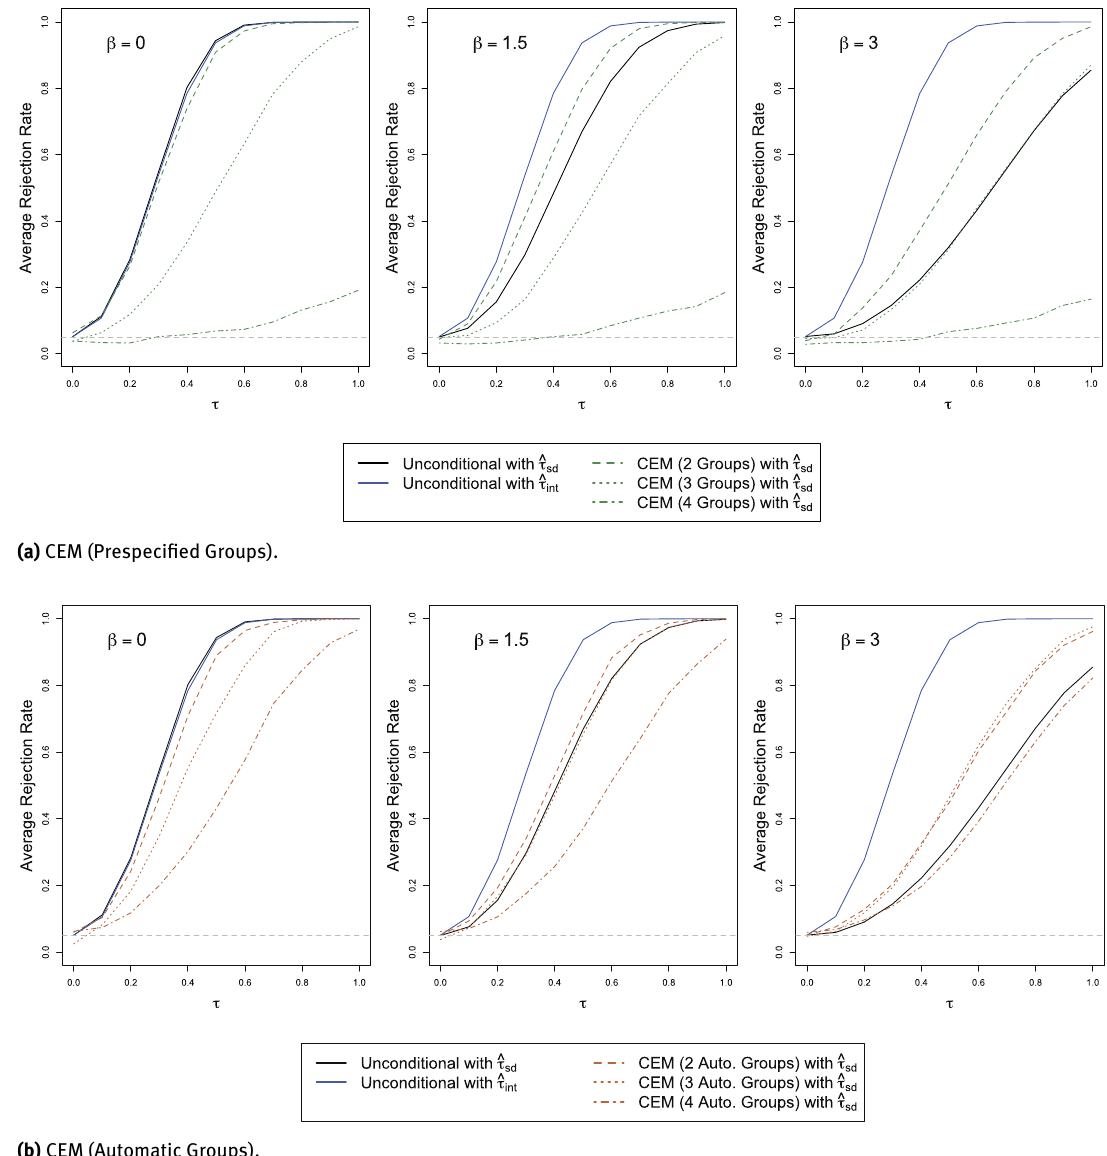
Figure 2: Average rejection rate (power) of Fisher’s Sharp Null for the CEM (Prespecified Groups) and CEM (Automatic Groups) procedures for various number of groups for each covariate. Also shown are results for the unconditional tests using ̂ τ sd and ̂ τ int , which are the same results from Figure